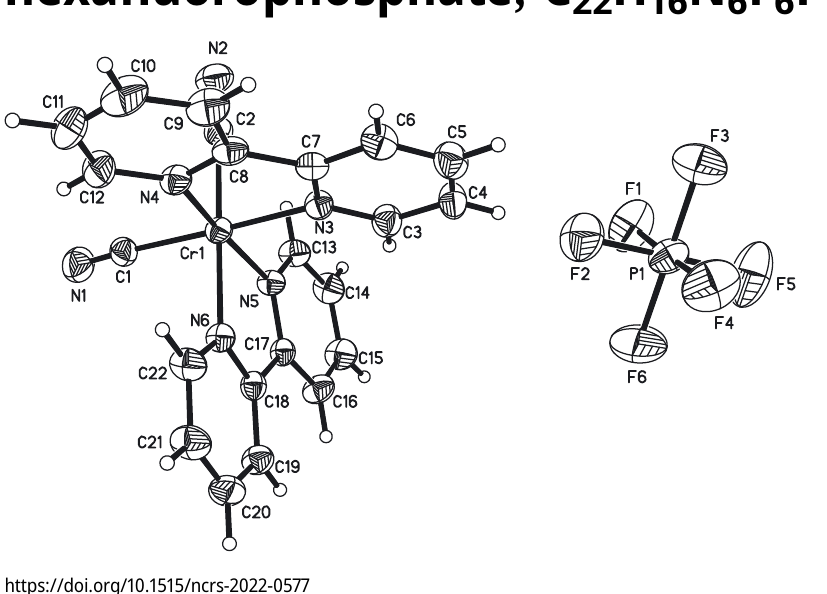
Table  : Data collection and